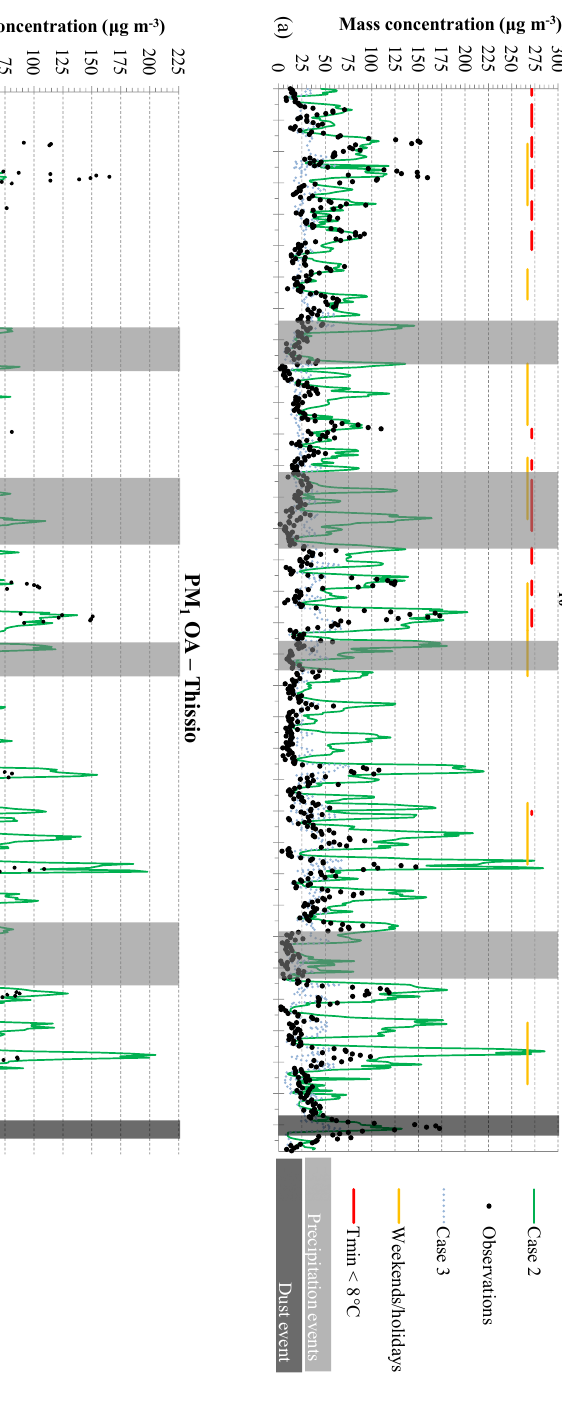
Figure 4. Time series of the hourly concentrations (µgm − 3 ; left axis) of the (a) total PM 10 mass, (b) submicron organic aerosol (PM 1 OA) and (c) submicron black carbon (PM 1 BC) from the COSMO-ART application (case 2, green line) and the measurements (black dots). The RWB fraction (%) of black carbon (BC wb ), as predicted (case 2) and observed, is shown by the grey and the black line, respectively (right axis). The cold nights (intense RWB smog episodes) and the weekends and holidays are shown by the red and yellow line, respectively. The shadowed areas indicate the rainy events (in light grey) and the dust event (in dark